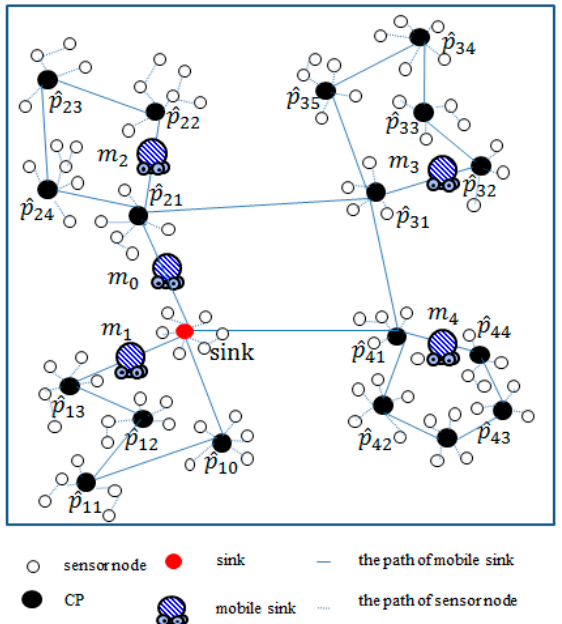
Figure 1. An example of the considered network environment.